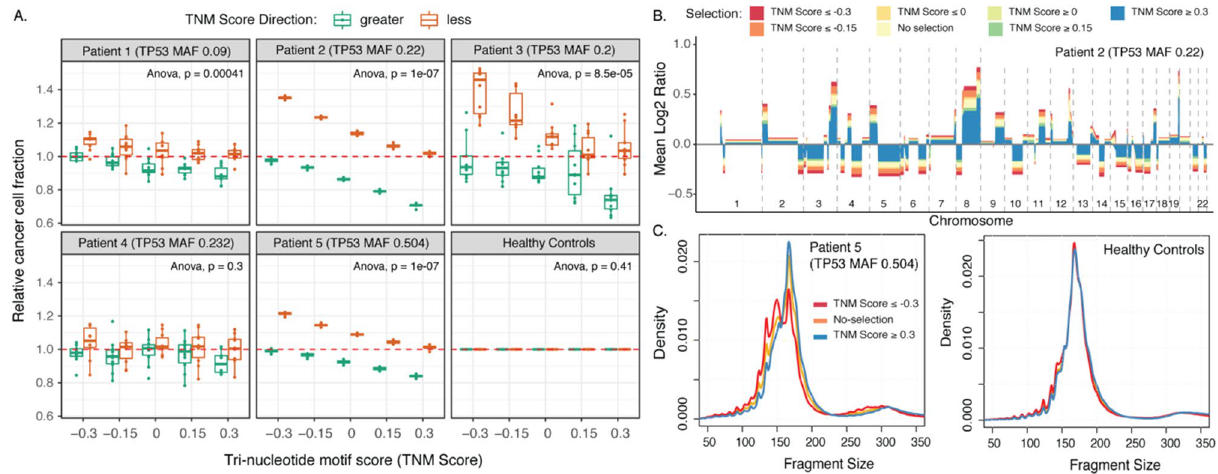
Figure 4. Tri-nucleotide motif score. ( A ) Copy number aberration analysis of all technical replicates containing fragments with tri-nucleotide motif scores less than or greater than − 0.3, − 0.15, 0, 0.15, and 0.3. The CCF of all the random samples is shown relative to median CCF from unselected data. ( B ) The average relative copy number values from the 10 replicates of patient 2. The different colors indicate results from using fragments with no selection, fragments with tri-nucleotide motif score less than or equal to − 0.3, − 0.15, 0, and greater than or equal to 0, 0.15, 0.3. ( C ) The fragment size distribution in the control pool and HGSOC patient 5 of fragments with no selection, fragments with tri-nucleotide motif score less than or equal to -0.3 and greater than or equal to